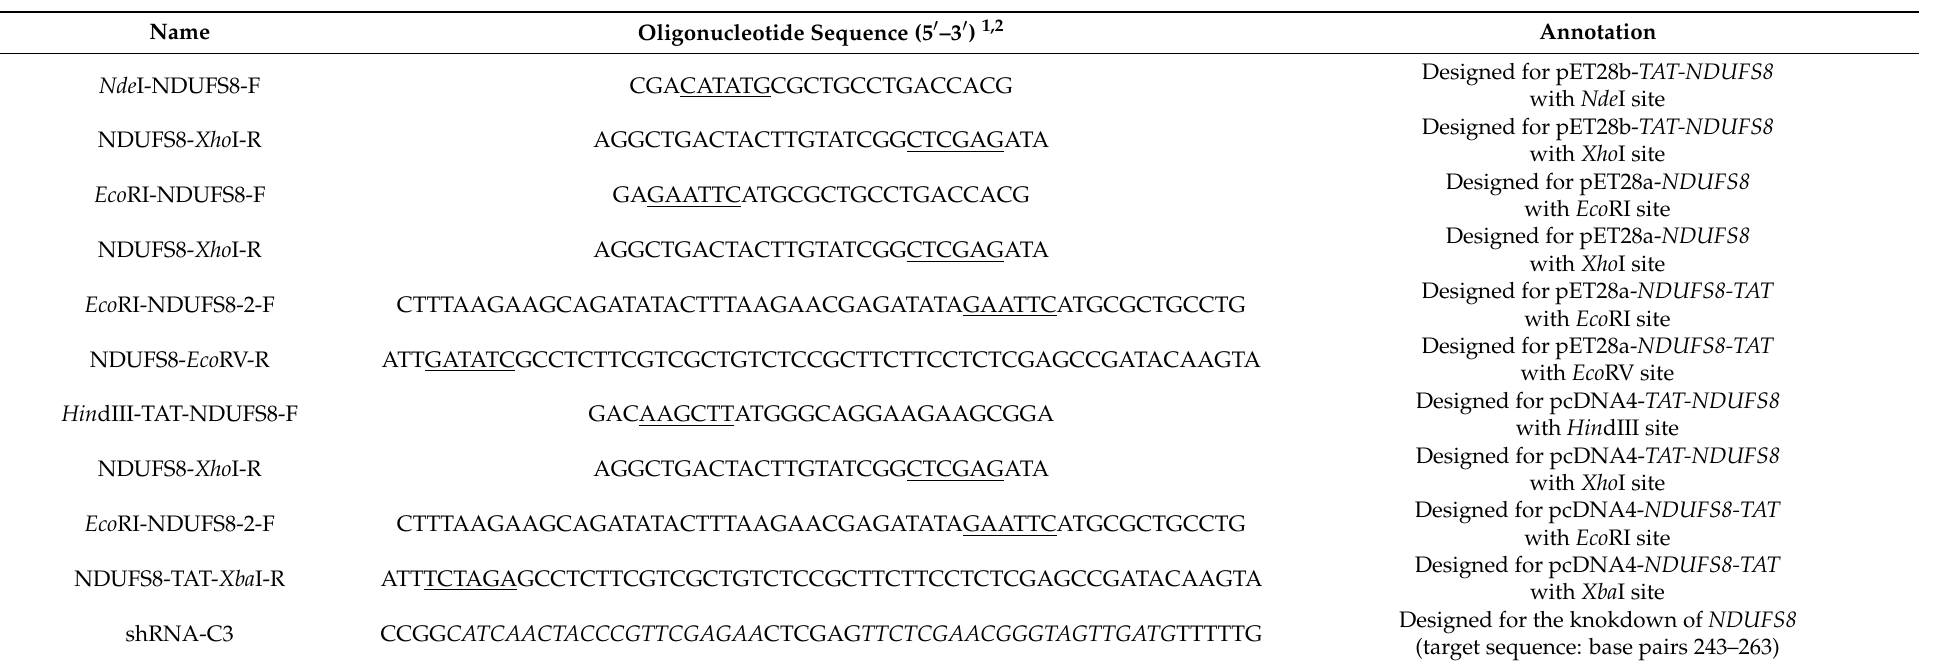
Table 1. The sequences of primers used in this